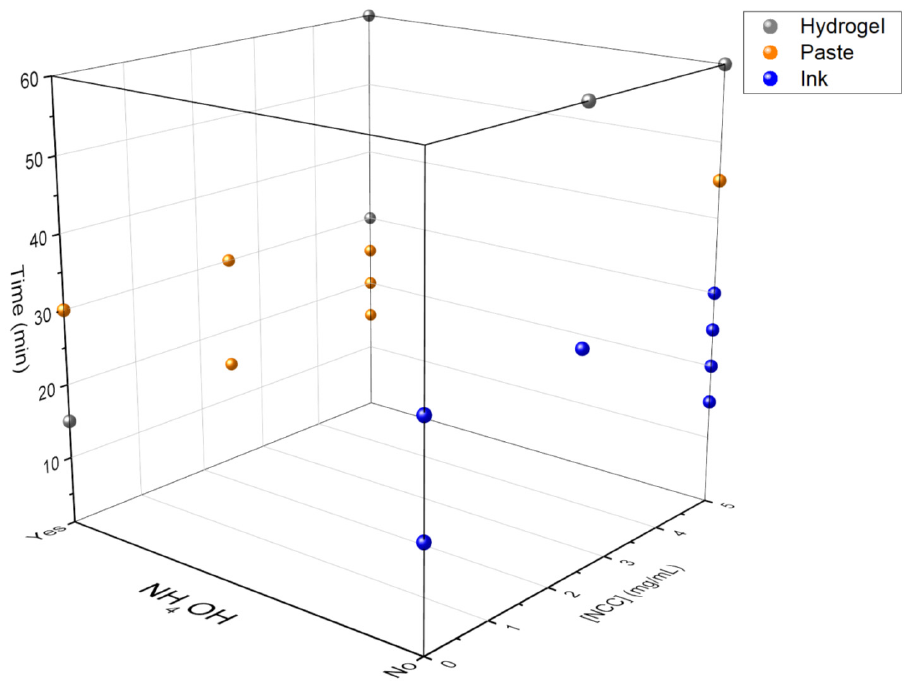
Figure 2. Three-dimensional scatter plot representing the conditions to obtain inks (blue), viscous pastes (orange) and self-standing hydrogels (gray). The effect of adding aqueous ammonia is herein represented, at different amounts of CNTs.